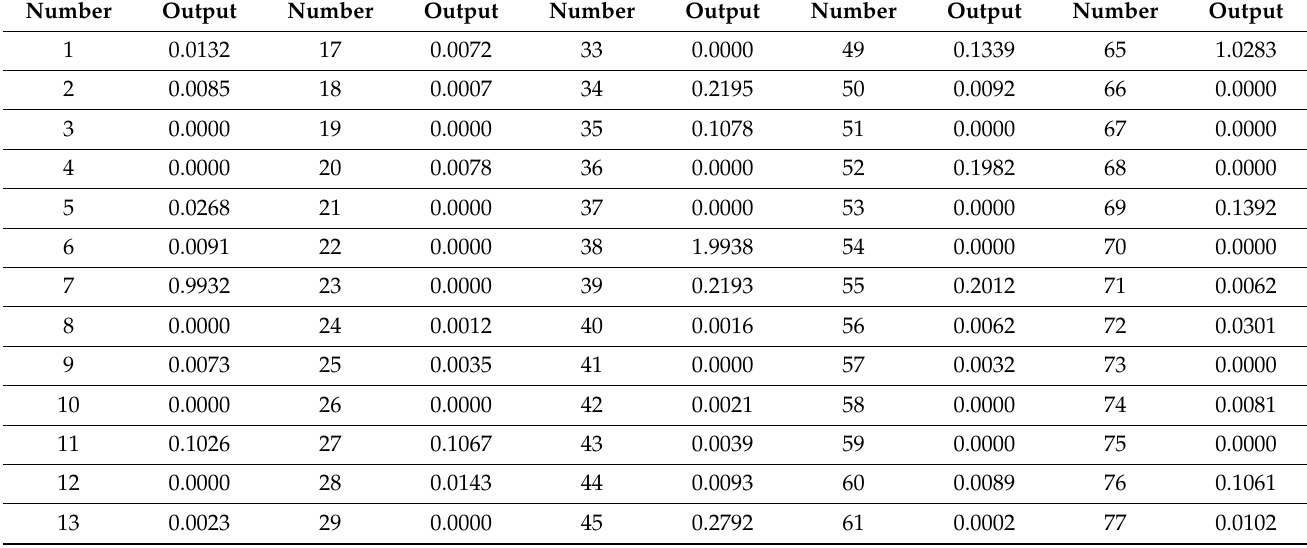
Table 10. Input results for aggressive test samples.